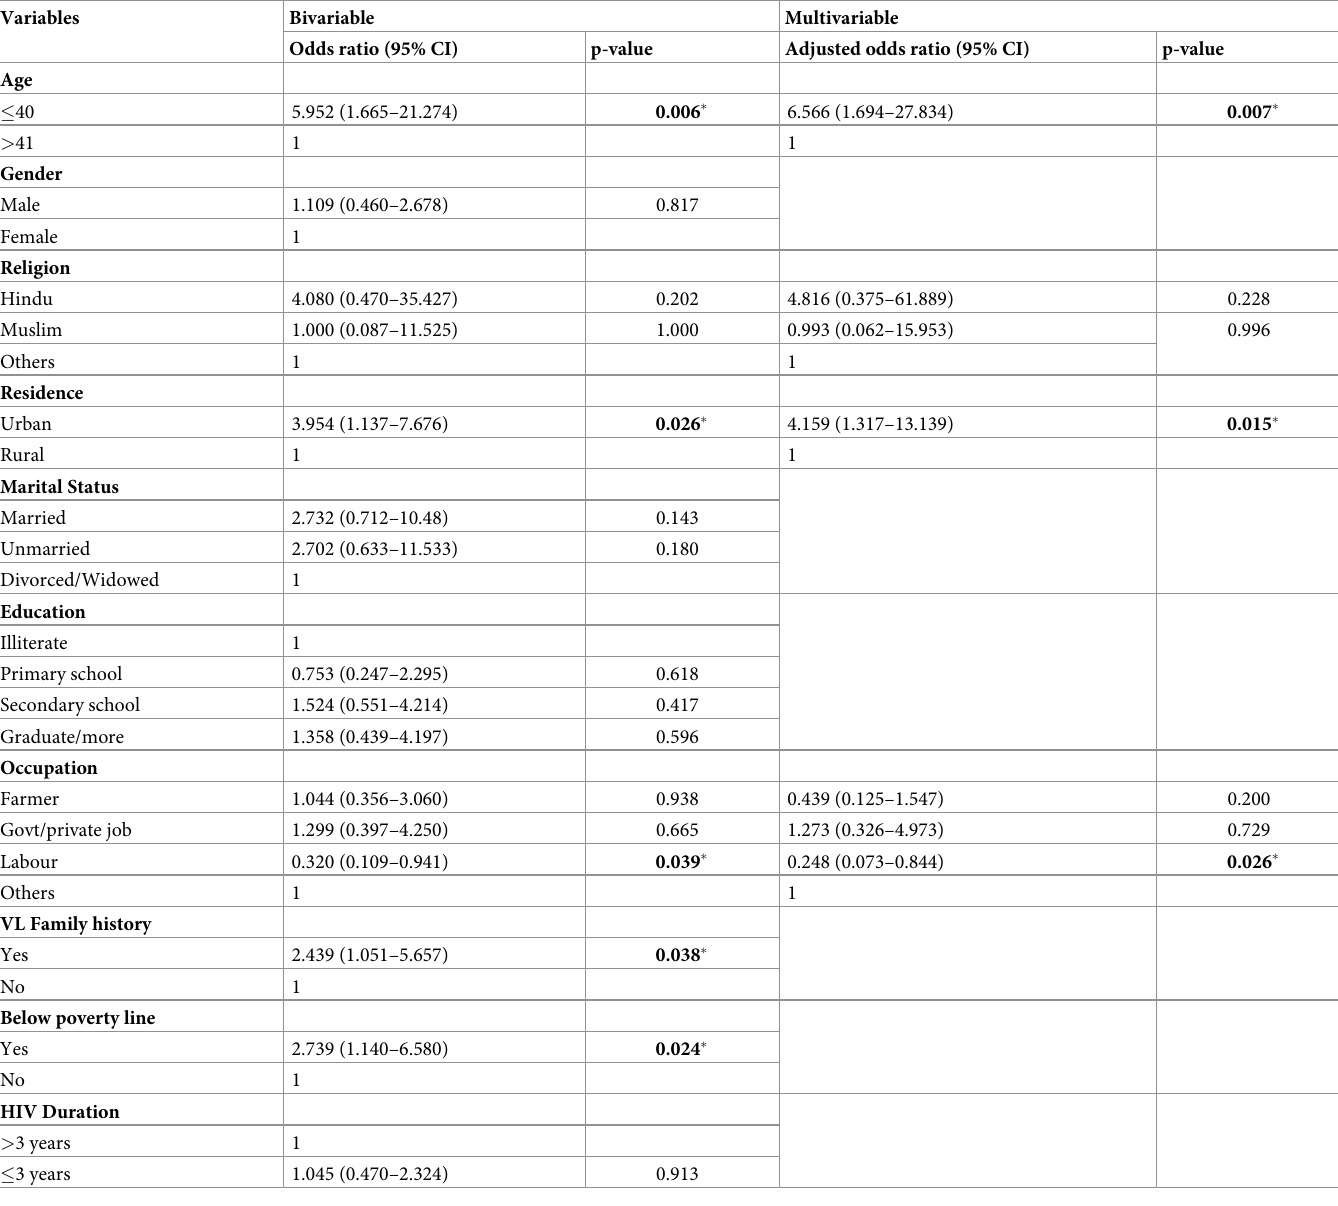
Table 7. Bivariable and multivarible logistic regression analysis showing predictors of practice